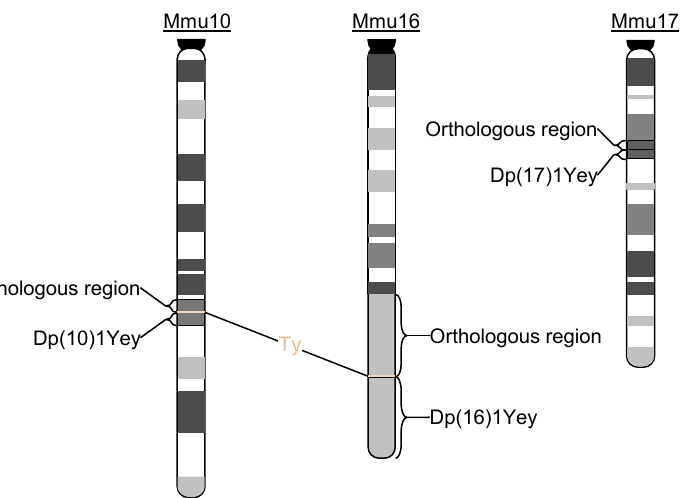
Figure 1. Presence of the Ty transgene at the breakpoints of Dp(10)1Yey and Dp(16)1Yey but not Dp(17)1Yey.